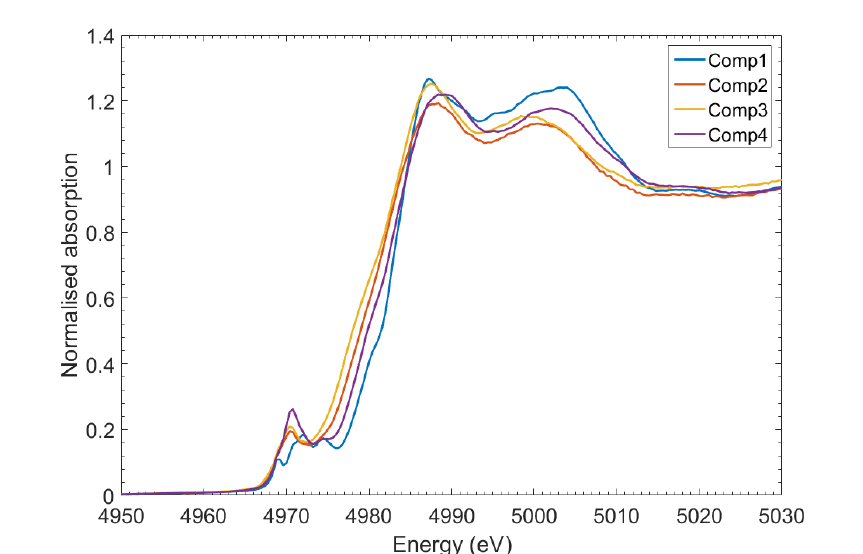
Figure A2. XANES portion of pure spectral components obtained through MCR-ALS applied to operando Ti k-edge data set. The comparison shows shift of edge position to lower energies upon sodiation as well its partial recovery upon